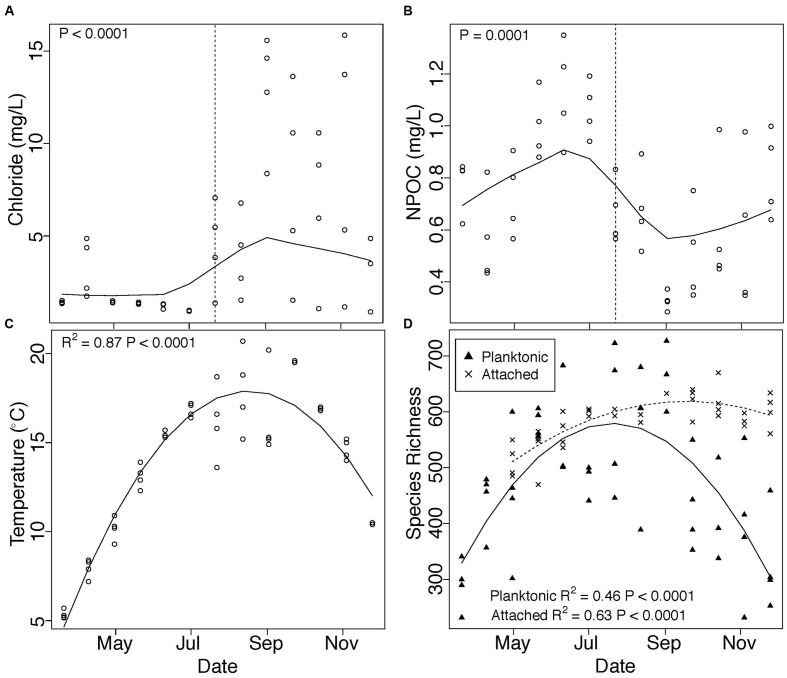
Changes in (A) chloride concentration, (B) NPOC concentration, (C) temperature, and (D) species richness across our sampling period are depicted in Figure 1. Chloride and NPOC concentration show abrupt shifts beginning at our July 22 sampling point (vertical dashed lines). P-values in (A) and (B) denote one-sided Mann-Whitney U test results of samples taken before versus on or after July 22, while trends through time in (A) and (B) are displayed using locally weighted scatterplot smoothing (LOWESS). Quadratic polynomials were fit to temperature and species richness data and plotted in (C,D). Triangles in (D) represent planktonic communities; X’s represent attached communities.